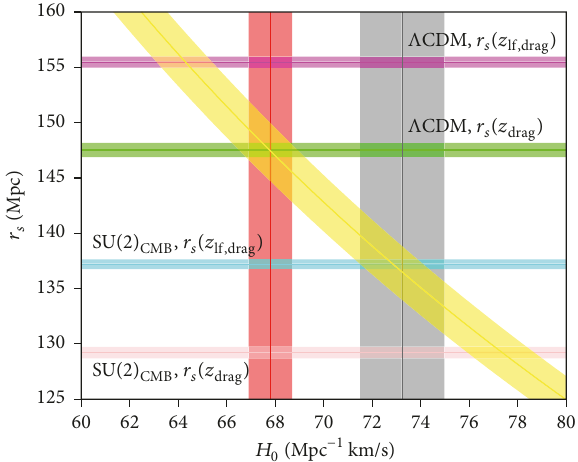
) - 𝐻 Figure 3: The 𝑟 𝑠 (𝑧 0 relation (curved band) of [30] in lf , drag ) and 𝑟 (𝑧 ) confrontation with the high- 𝑧 predictions of 𝑟 𝑠 (𝑧 𝑠 lf , drag drag in Λ CDM and SU (2) (horizontal bands) of (17). Vertical bands CMB indicate the values of 𝐻 0 extracted in [38] (low) and in [34] (high). Note that there is a ∼ 3 𝜎 tension. However, a ∼ 7 𝜎 discrepancy exists between the 𝐻 0 values of (64.3 ± 1.1) kms −1 Mpc −1 and (72.9 ± 1.2) kms −1 Mpc −1 associated with the intersections of 𝑟 (𝑧 ) 𝑠 lf , drag ) - 𝐻 in Λ CDM and in SU (2) , respectively, with the 𝑟 𝑠 (𝑧 0 CMB lf , drag relation. Taking 𝐻 0 = (73.24 ± 1.7) kms −1 Mpc −1 from [34] the discrepancy between this value and (64.3 ± 1.1) kms −1 Mpc −1 is about 5𝜎